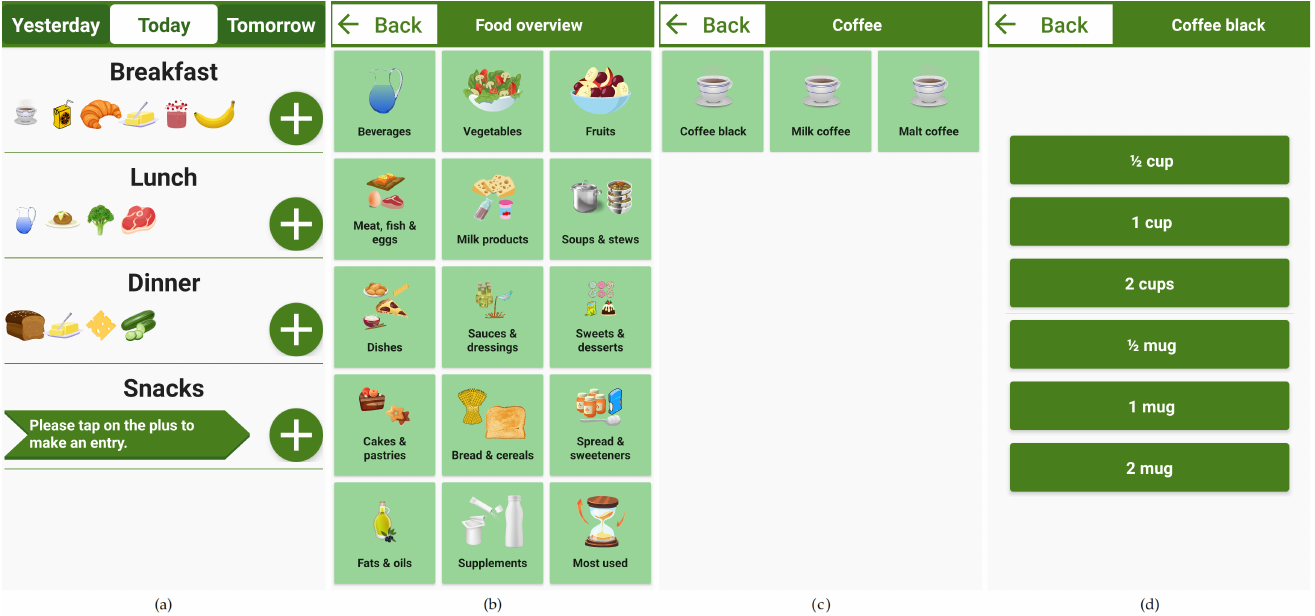
Figure 2. Partially completed nutrition diary for a single day ( a ), including the navigation steps for selecting “Coffee black” ( b , c ) and the corresponding household quantity ( d ). The recording is started by clicking on the “Plus” button of a specific meal ( a ). Adding a cup or a mug of coffee to DNDv1 took five navigation steps in this case. Note: All screenshots were generated based on DNDv2. Therefore, the selection of the day only allows yesterday, today, or tomorrow and the two categories “Most used” and “Supplements” can be seen. Furthermore, the subcategory overview “Coffee” was omitted for clarity, and the original application evaluated in German was